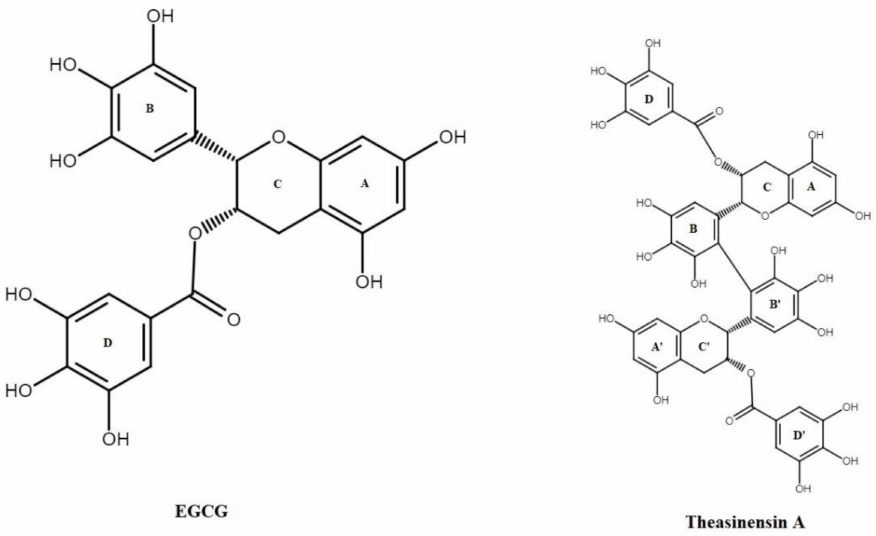
Figure 1. Structure of EGCG and theasinensin